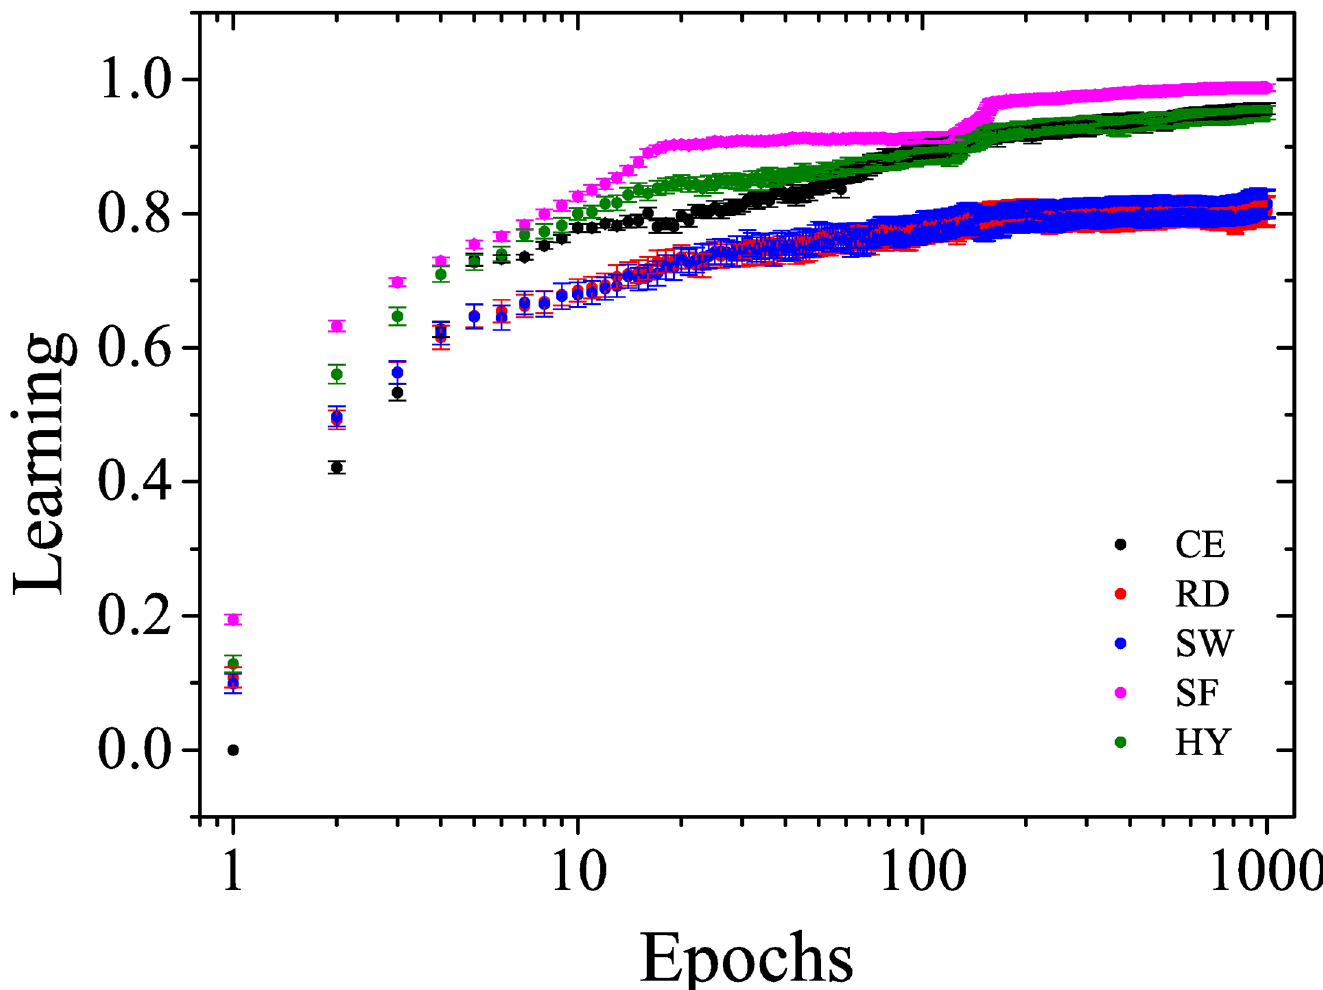
Fig 5. Learning curves of the neural network of C. elegans and the random, small-world, scale-free and hybrid artificial neural